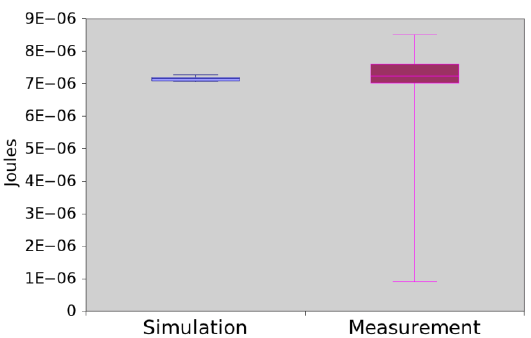
Figure 16. Power consumption of